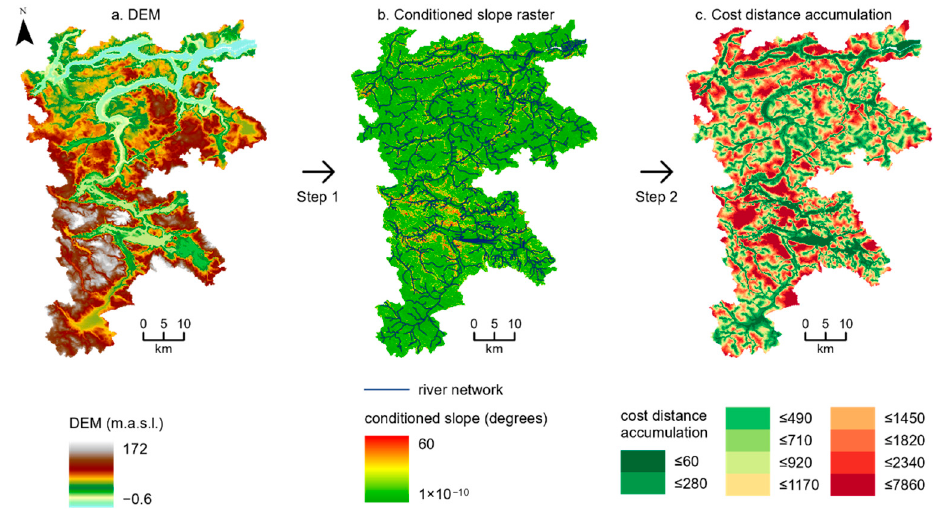
Figure 7. Initial steps that our approach takes to delineate the river valley bottom using an example of the Gudenå drainage basin. At Step 1, using ( a ) the DEM as input, we calculate slope and condition it to remove values of zeros, which results in ( b ) a conditioned slope raster. At Step 2, we use ( b ) together with the river network as inputs to calculate ( c ) the cost distance accumulation within the drainage basin.